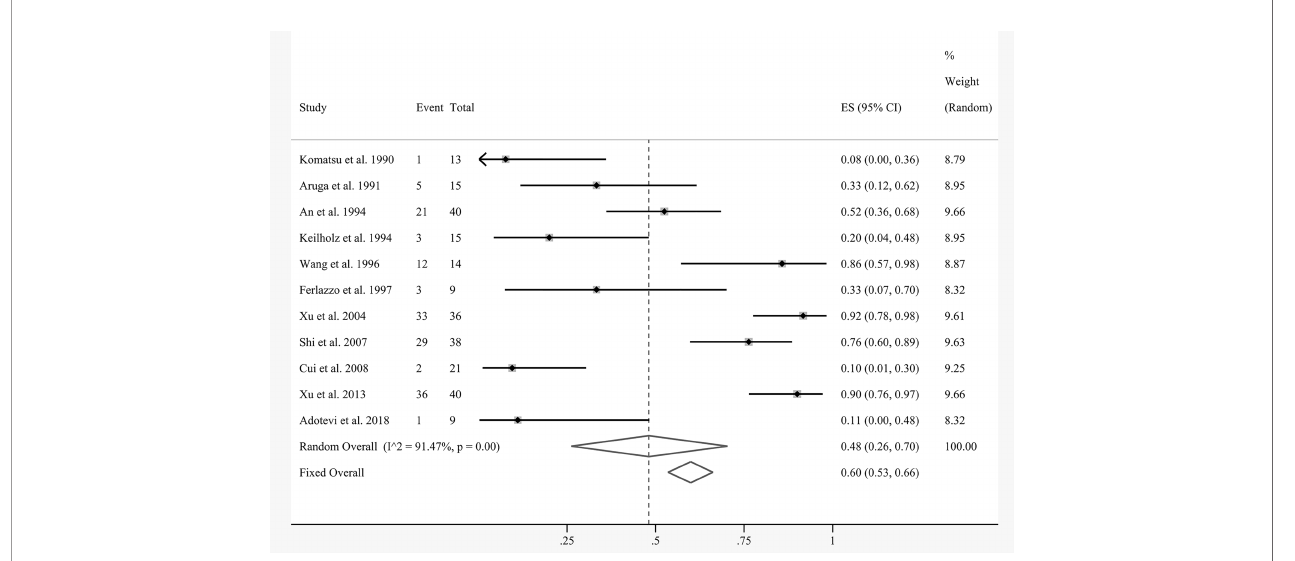
FIGURE 4 | Forest plot showing pooled analysis of ORR.